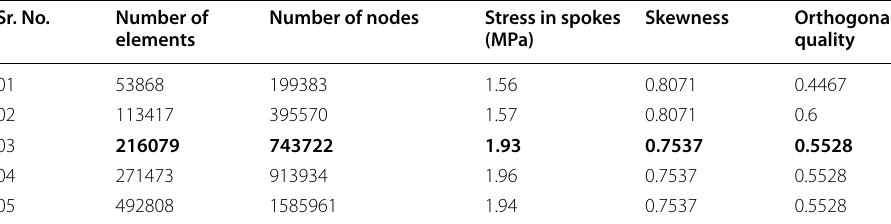
Table 3 Number of elements and nodes, skewness, orthogonal quality, and maximum stress values for mesh convergence analysis of HC-A1 NPT Sr. No.